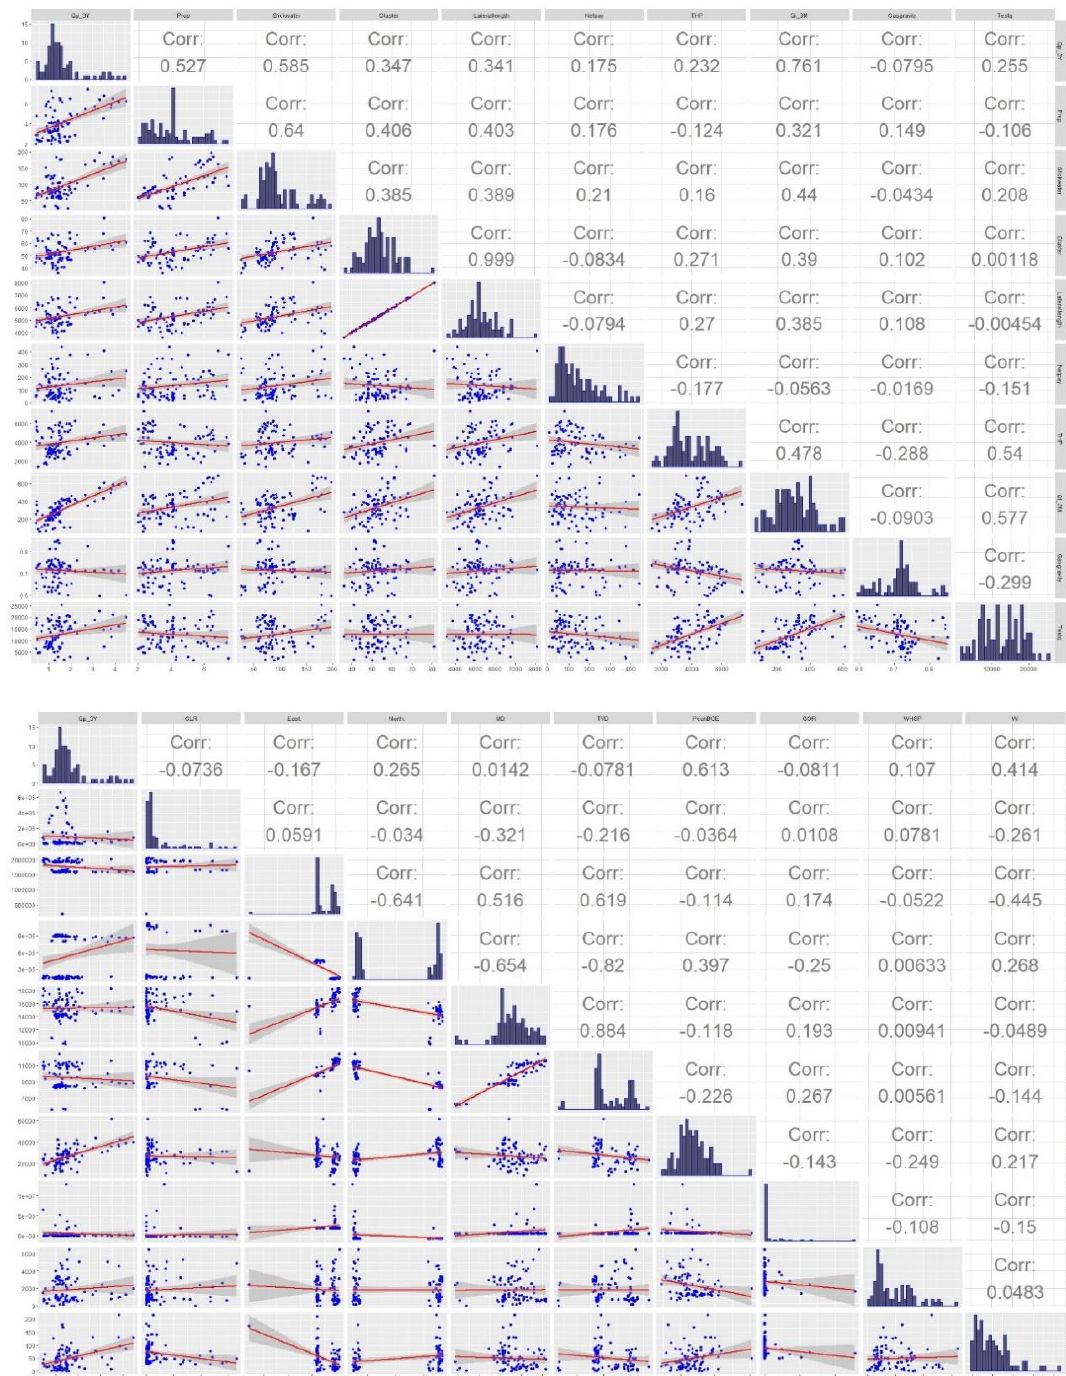
Figure 6. Pearson correlation matrix and distribution of data used in the datasets.